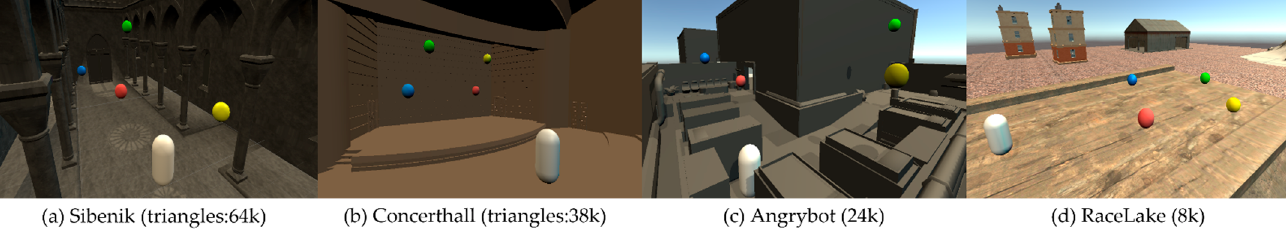
Figure 5. Four benchmark scenes: ( a ) sibenik (indoor)—64k; ( b ) concerthall (indoor)—38k; ( c ) angrybot (indoor + outdoor)—24k; ( d ) racelake (indoor + outdoor)—8k.